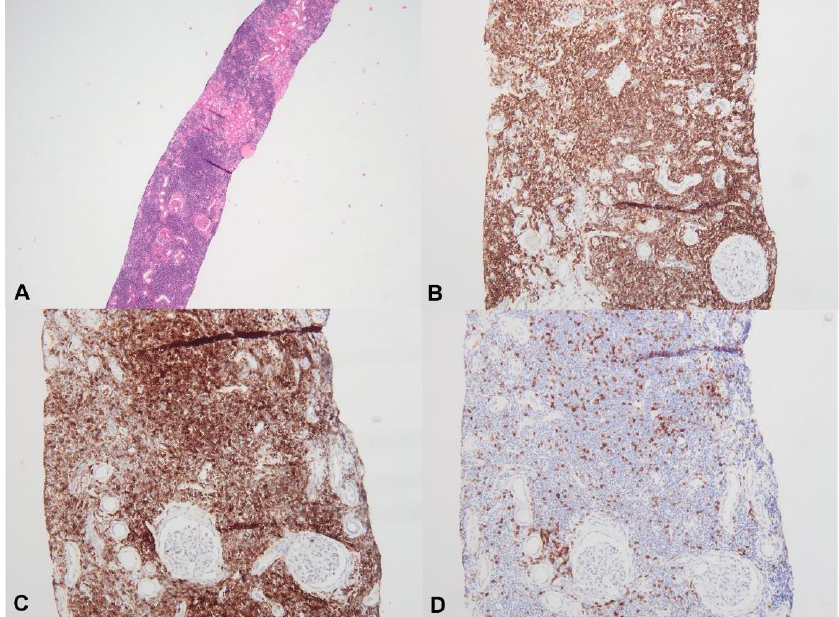
Figure 3. Diffuse interstitial infiltration by chronic lymphoid leukemia cells ( A ), hematein eosin saffron ×20) positive for CD20 (( B ), ×100) and CD5 (( C ), ×200), whereas immunohistochemistry with anti-CD3 antibody is negative on tumoral cells ( D ), ×200).